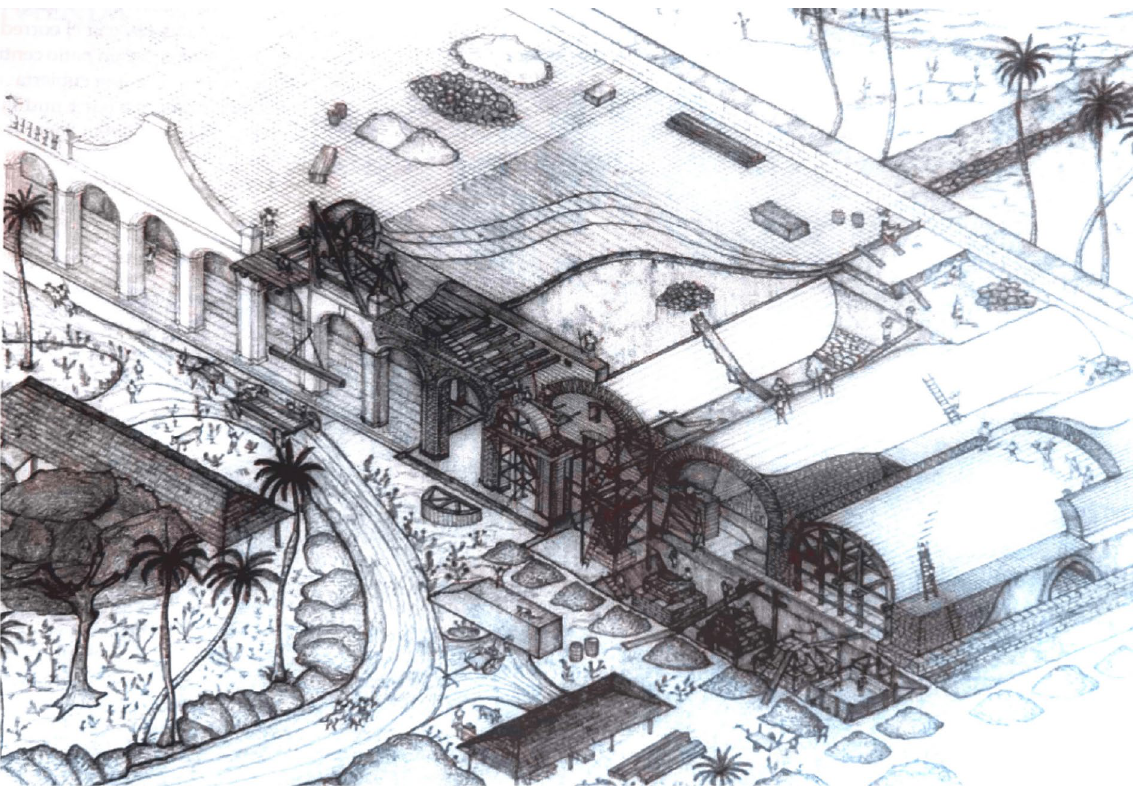
Fig. 12 The Vaults of Santa Clara or Barracks of the Vaults, (Cabrera Cruz et al.